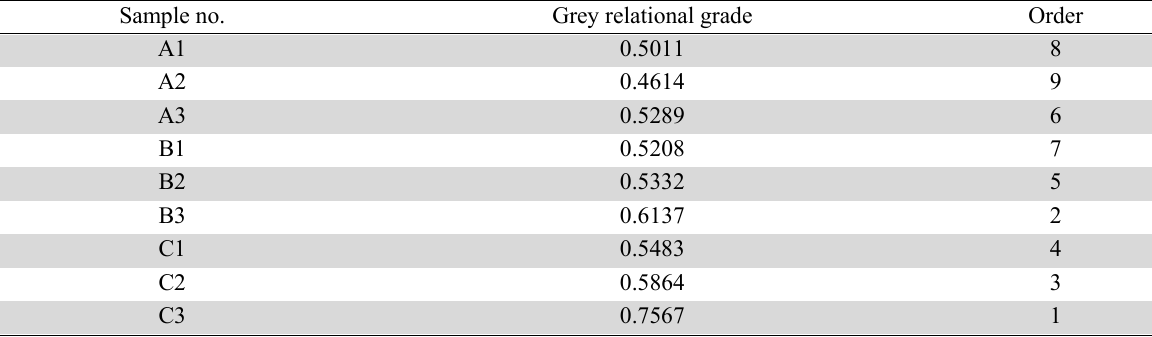
Grey relational grades and their order Sample no.